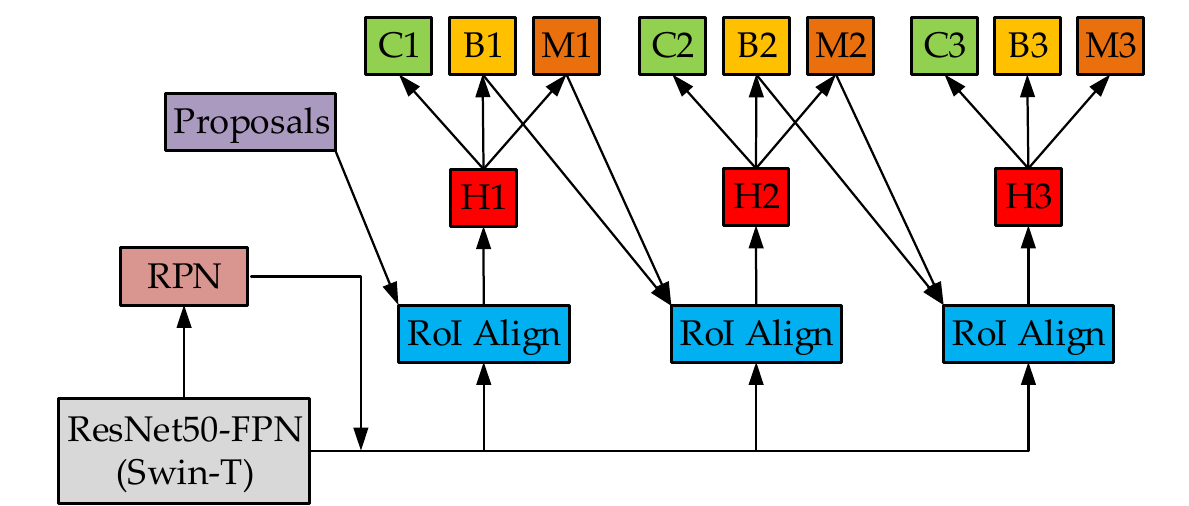
Figure 3. Cascade Mask R-CNN network structure diagram.